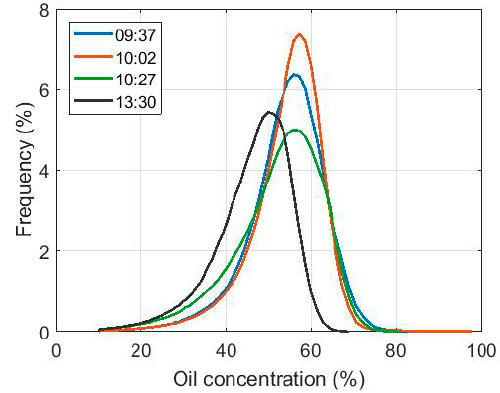
Figure 13. Normalized histograms of oil concentration estimated within the mineral oil slick released during the MOS Sweeper exercise. Temporal measurements at 09:37 (blue), 10:02 (red), 10:27 (green) and 13:30 UTC (black).